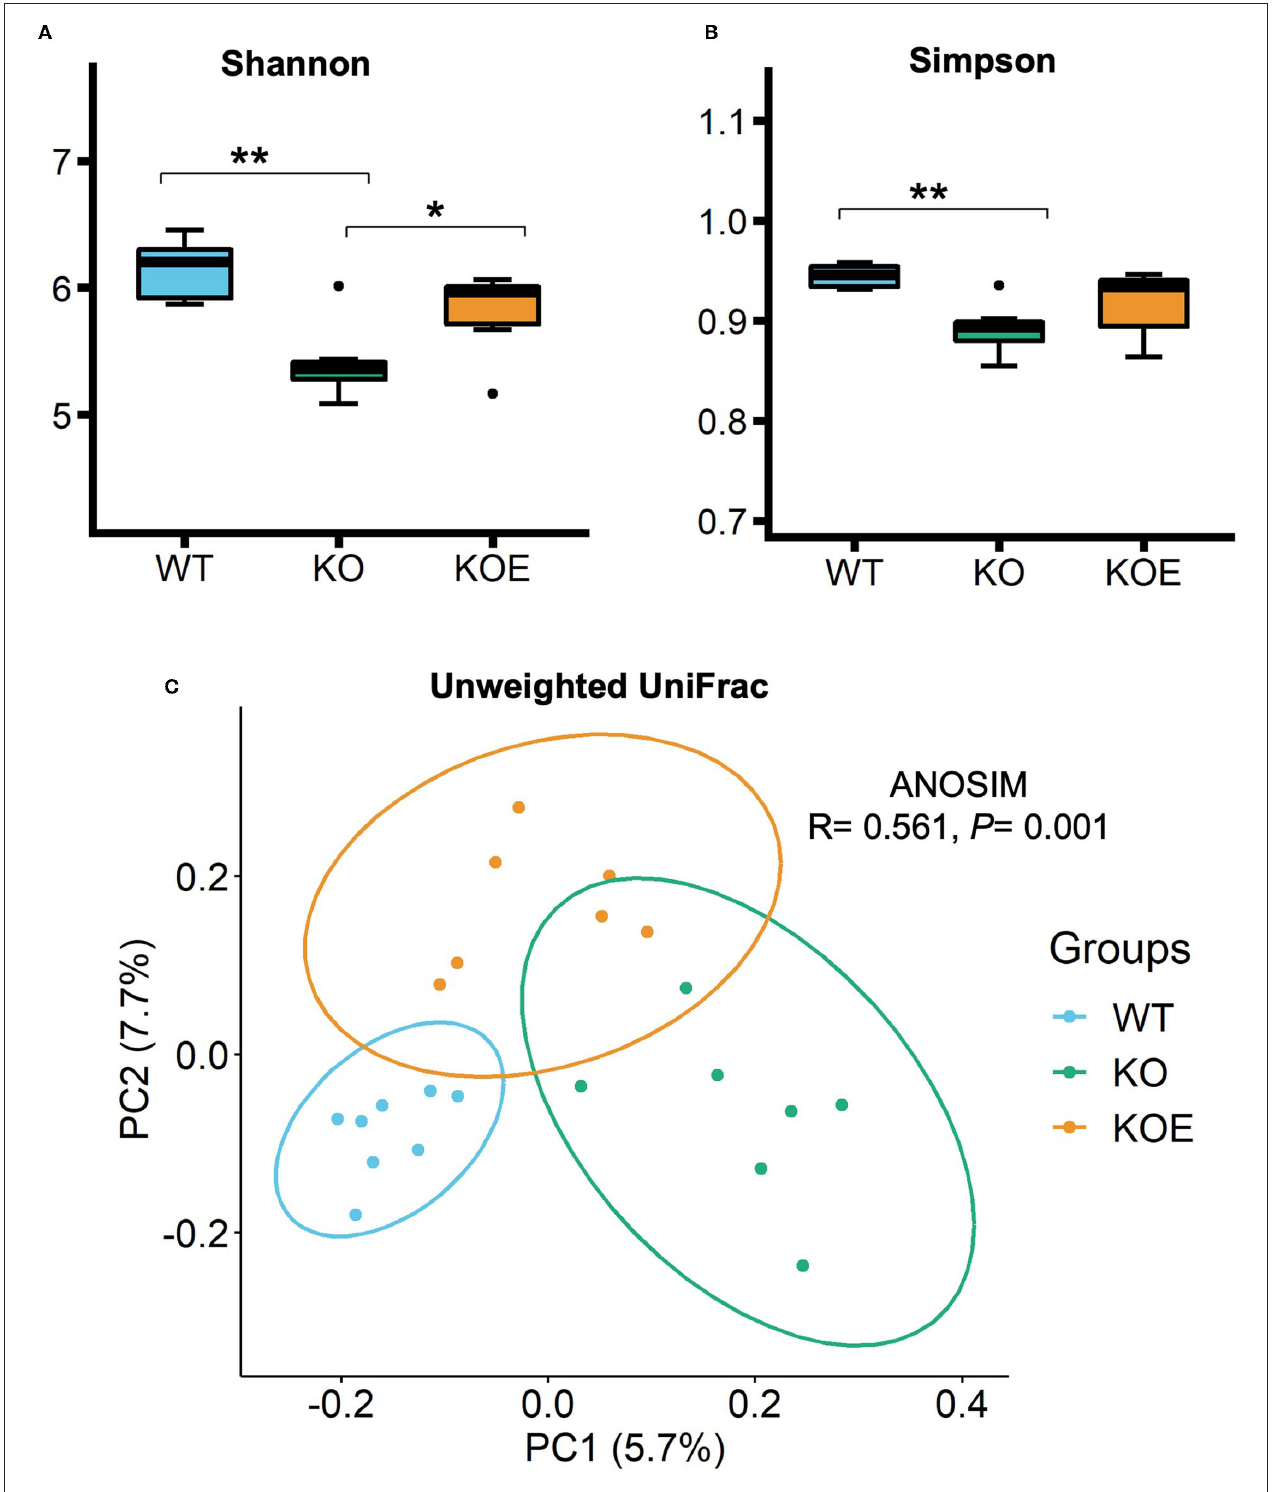
FIGURE 2 | The α - and β -diversities of gut bacteria in mice of treatment groups [wild-type (WT): n = 8, IL10 − / − (KO) and KO with eggshell membrane supplementation (KOE): n = 7, respectively]. After the 19-week treatment, total bacterial DNA in cecal contents were extracted for 16S rRNA gene sequencing. Gut bacterial diversity and richness within samples were measured by (A) Shannon and (B) Simpson indices. The principal component analysis (PCoA) of Unweighted UniFrac (C) and ANOSIM analysis were conducted to compare the gut bacterial profiles among the three groups. Statistical analysis of α -diversity data was performed by ANOVA and the Tukey-Kramer test. * P < 0.05, ** P < 0.01. The dots (•) in the boxplots indicate outliers.